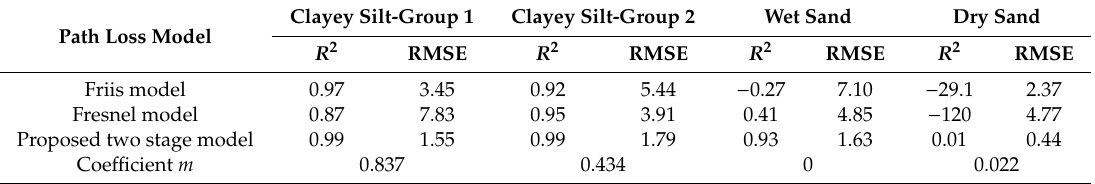
Table 3. R 2 and Root Mean Squared Error (RMSE) of different models.